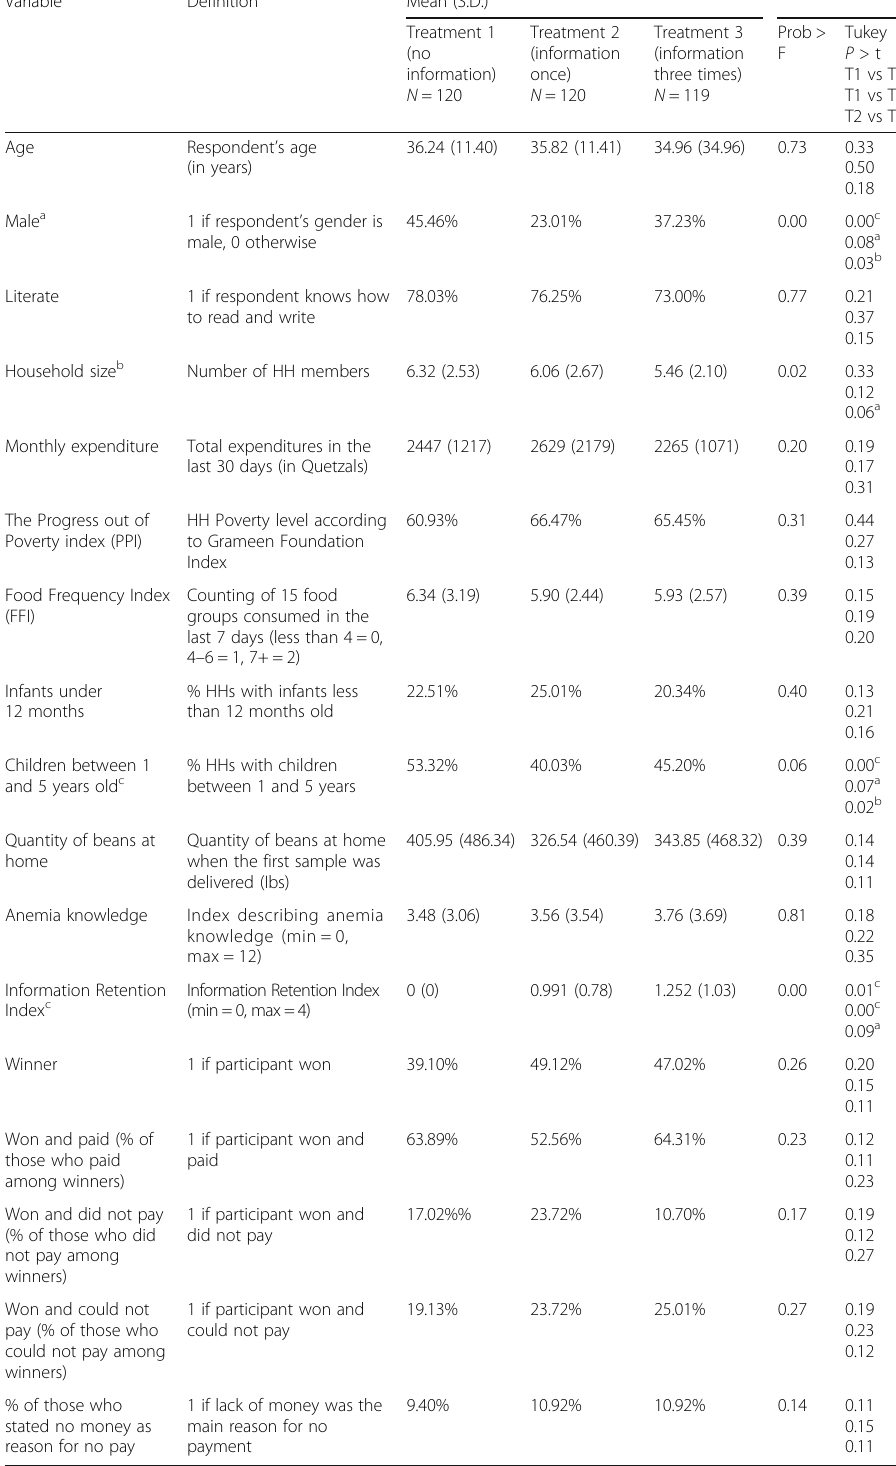
Table 2 Social and economic characteristics by treatment group (ANOVA test and pairwise